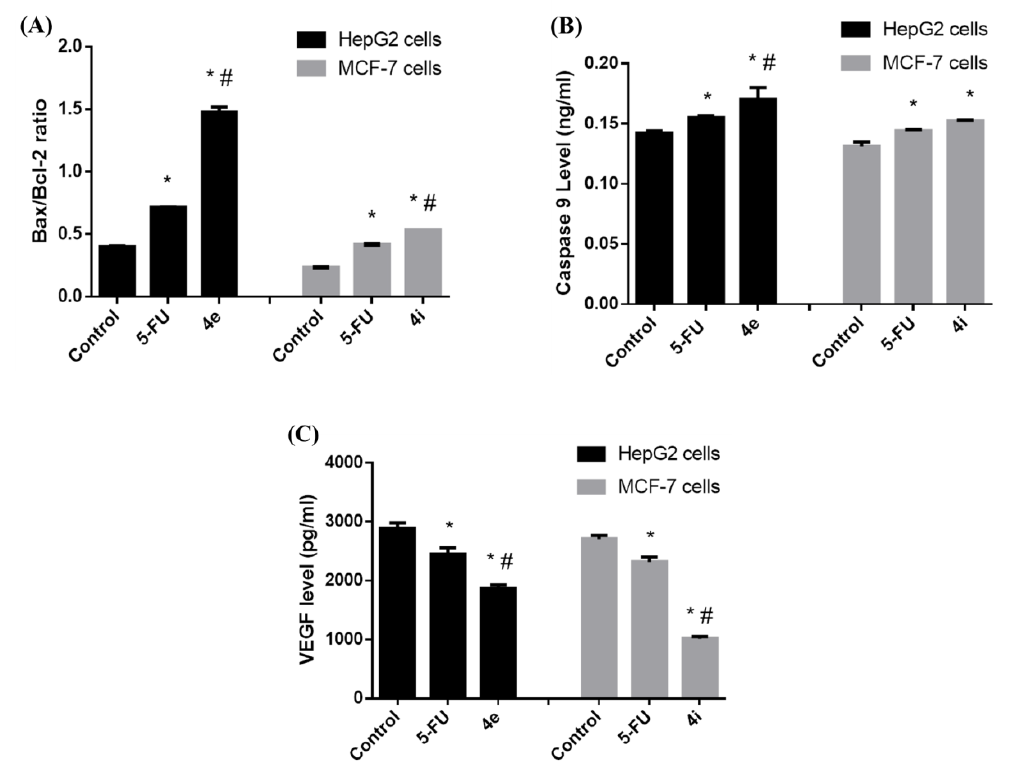
Figure 7. The effect of 4e and 4i compounds on the ( A ) Bax/Bcl-2 ratio, ( B ) caspase 9 level, and ( C ) VEGF level. Data are expressed as the mean ± standard deviation for triplicates within an individual experiment. Statistical significance was performed using one-way ANOVA. * p < 0.05 vs. Control, # p < 0.05 vs.